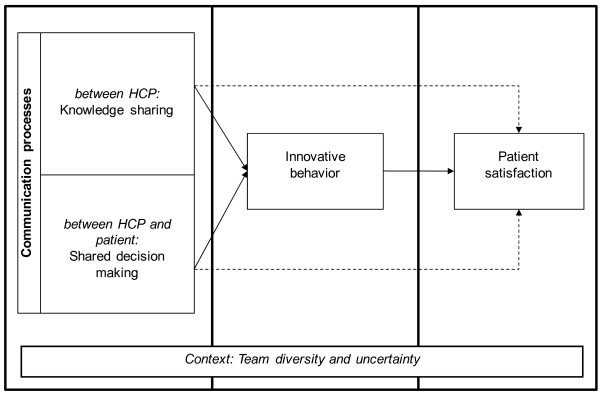
Study framework.